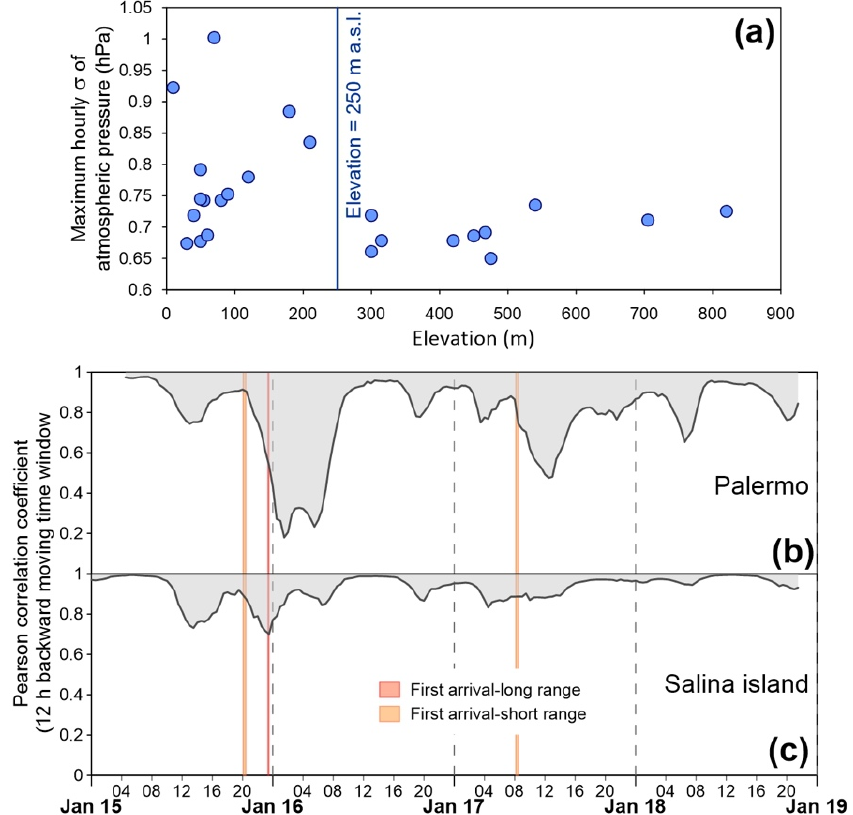
Figure 7. ( a ) Maximum hourly standard deviation ( σ ) of atmospheric pressure plotted versus elevation of the stations; ( b ) Pearson correlation coefficient of 30 min values of instant atmospheric pressure (12 h backwards moving time window) of the sea level station of the TROPOMAG network at Palermo, plotted versus the same data acquired at higher elevation; ( c ) the same data for Salina island. Vertical bars, as in Figure